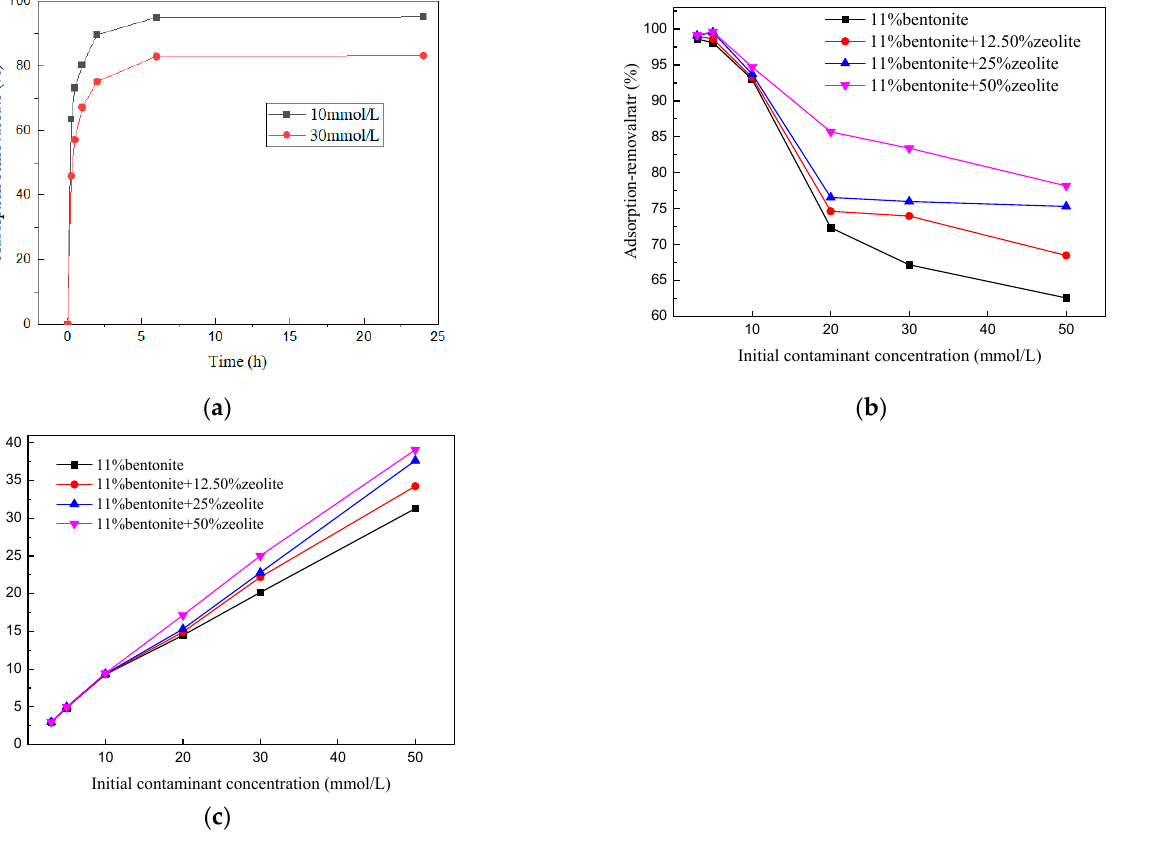
Figure 8. ZnCl 2 concentration stone chip-bentonite-zeolite mixture zeolite dopants simultaneously varied the stone chip-bentonite-zeolite mixture sorption and removal rates. ( a ) removal rate vs. adsorption time; ( b ) removal rate vs. solution concentration; ( c ) adsorption concentration .